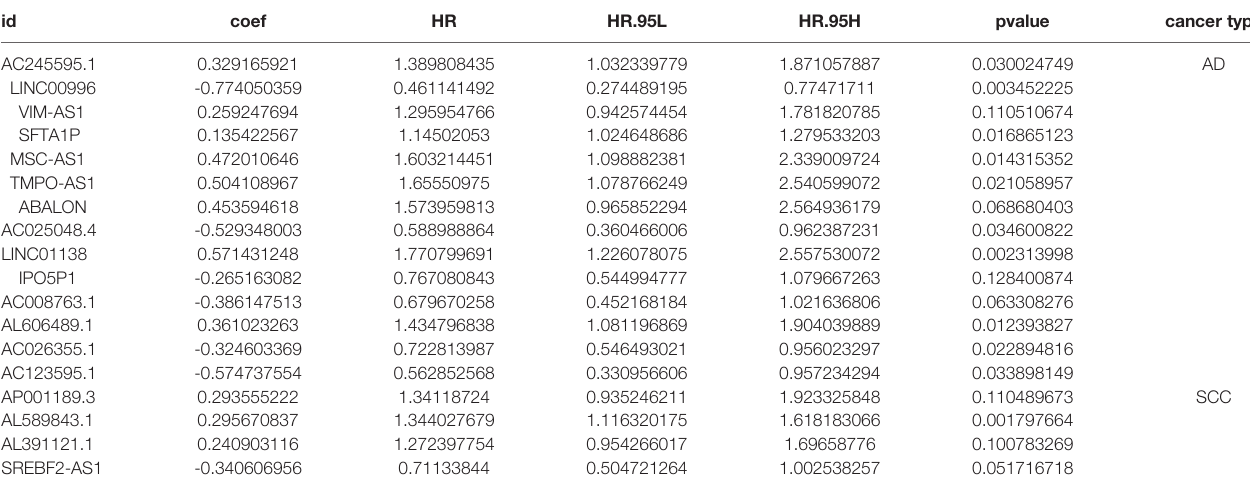
TABLE 1 | The signi fi cant LncRNAs screened via multiple Cox analysis for AD and SCC patients.